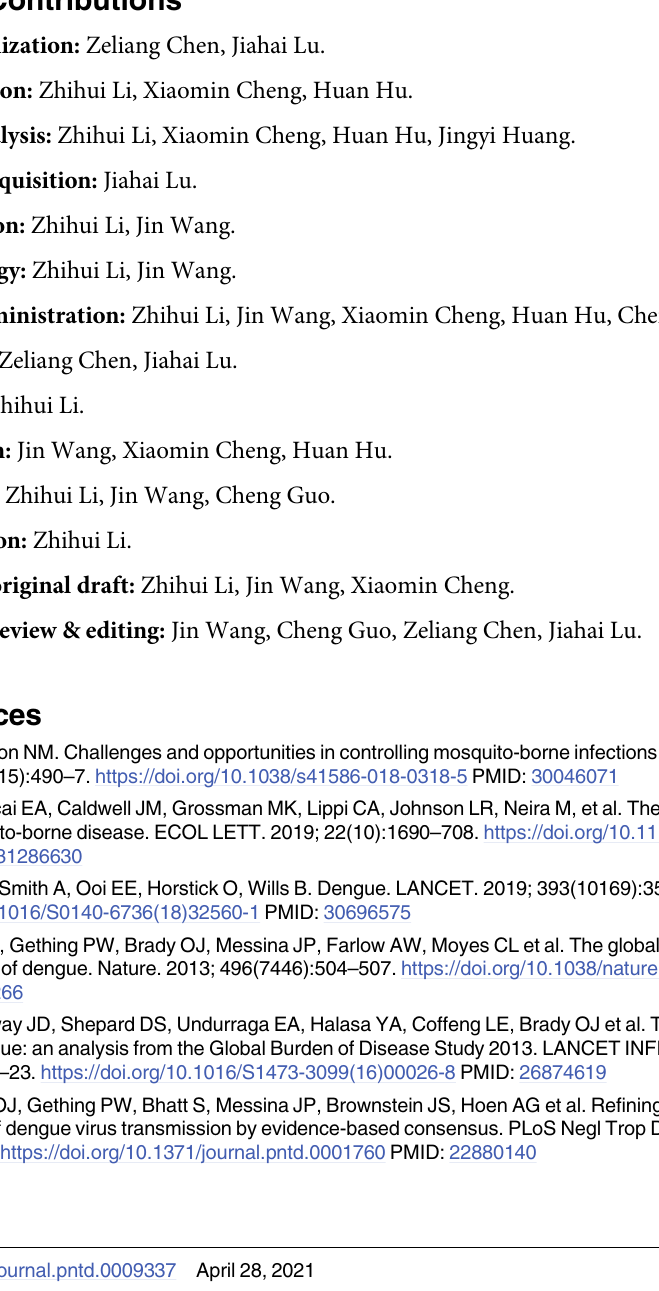
S4 Text. Information of cross-infection and nucleic acid detection. Table A. The publica- tions reporting cross-infection between any two of three arboviruses. Table B. The publications reporting both results of nucleic acid and antibody. Fig A. Forest plot of the pooled seropreva- lence of cross-infection. S5 Text. Assessments of the quality of the studies. Table A. Assessments of the quality of